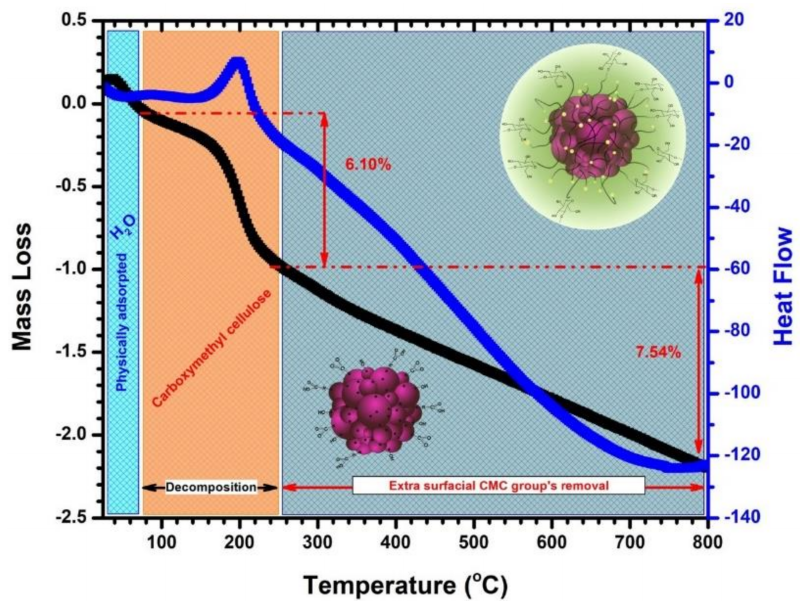
Figure 3. TG and DSC profile of as-prepared CF@CMC magnetic